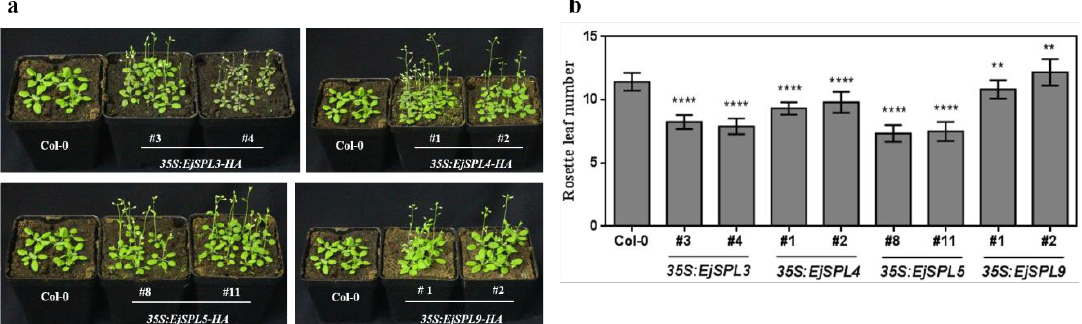
Figure 8. Overexpression of EjSPL3 , EjSPL4 , EjSPL5, and EjSPL9 in Arabidopsis promotes early flowering. ( a ) Phenotype of overexpression transgenic lines and wild Col-0. ( b ) The rosette leaf numbers of overexpression transgenic lines and Col-0 in ( a ). Error bars indicating SE from three biological replicates. The asterisk indicates a significant difference compared to the Col-0 ( n ≥ 15, Student’s t -test, ** p < 0.01, **** p < 0.00001).